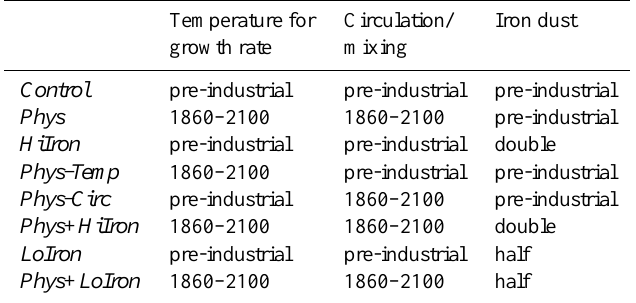
Table 3. Theoretical framework variable and parameter description.